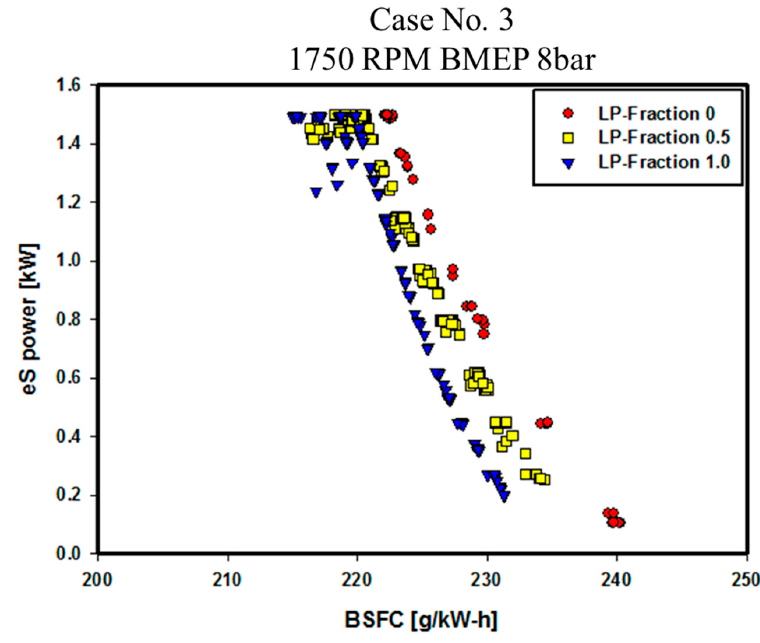
Figure 17. eS power di ff erence for various LP fractions on the Pareto front line of case 3.